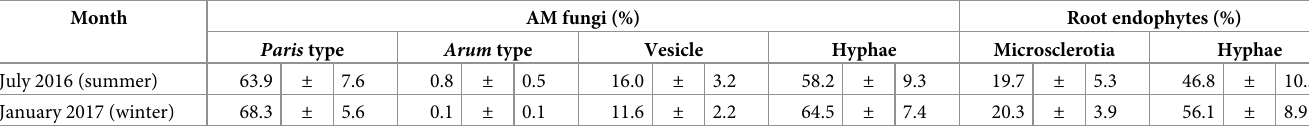
The percentages are shown as means ± standard error ( n =